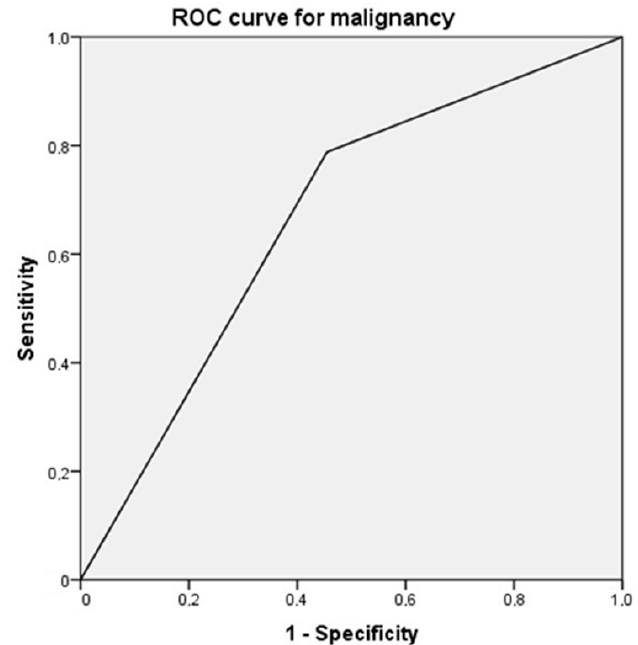
Figure 4. ROC (receiver operating characteristic) curve based on the diagnostic capacity of nestin positivity in relation to malignancy. The area under the curve was 0.667 ( p = 0.009).